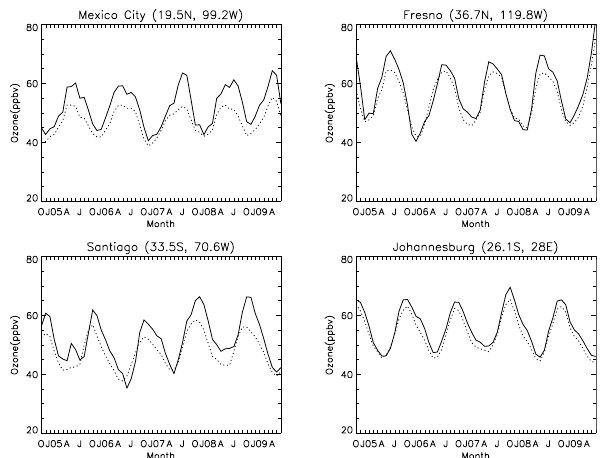
Fig. 10. Time series of monthly mean tropospheric ozone VMR at the 4 cities shown in Fig. 7 (solid lines) along with corresponding time series averaged over ± 5 ◦ in latitude and longitude around the city grid cell (dashed lines)(3 month running